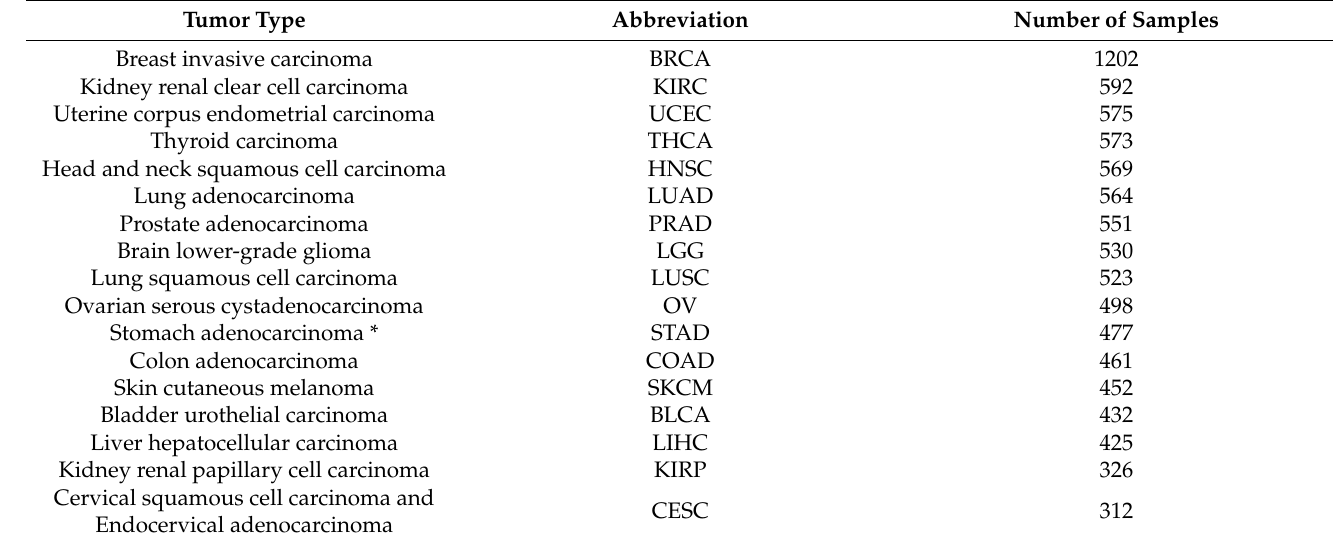
Table 1. Abbreviation for tumor type and the number of genomic data commons (GDC) from The Cancer Genome Atlas (TCGA) microRNA (miRNA) expression